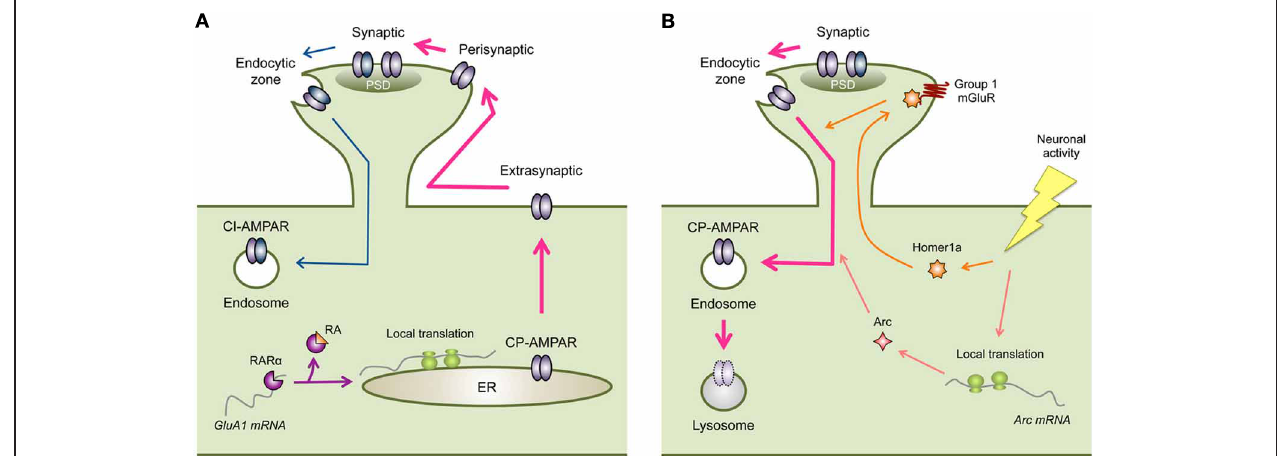
FIGURE 1 | Regulation of CP-AMPARs in homeostatic synaptic plasticity. (A) Inactivity-induced synaptic expression of CP-AMPARs. Inactivity leads to local synthesis of GluA1. One mechanism is via RA signaling, where RA binds to RAR α to relieve translational inhibition of GluA1 mRNA. Newly synthesized GluA1 containing CP-AMPARs are then eventually trafficked to the synapse (PSD, postsynaptic density). Cell surface expression of GluA1 containing CP-AMPARs is likely tied to phosphorylation of GluA1-S845. In visual cortex, the increase in extrasynaptic GluA1 leads to synaptic accumulation, however, in hippocampus an extra regulatory step from perisynaptic to synaptic trafficking may be needed. Inactivity driven synaptic localization of CP-AMPARs also depend on CaMKII β activity, which may act on GluA1-S831 phosphorylation. Synaptic expression of